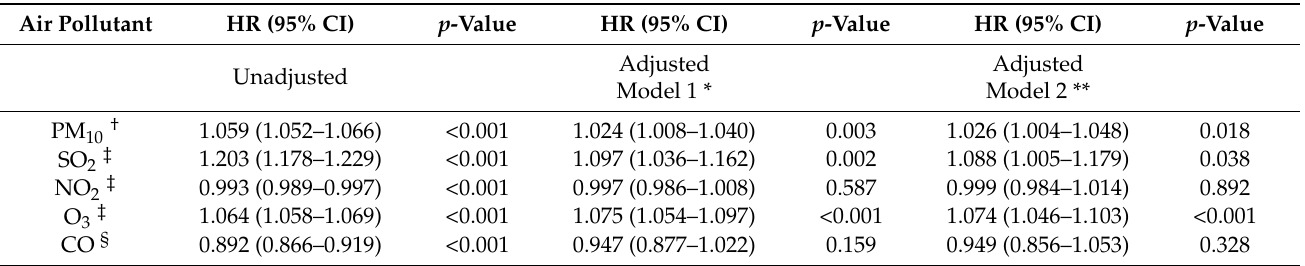
Table 2. Ambient particulate and gaseous air pollution and incidence of venous thromboembolism in the overall general population ( n =